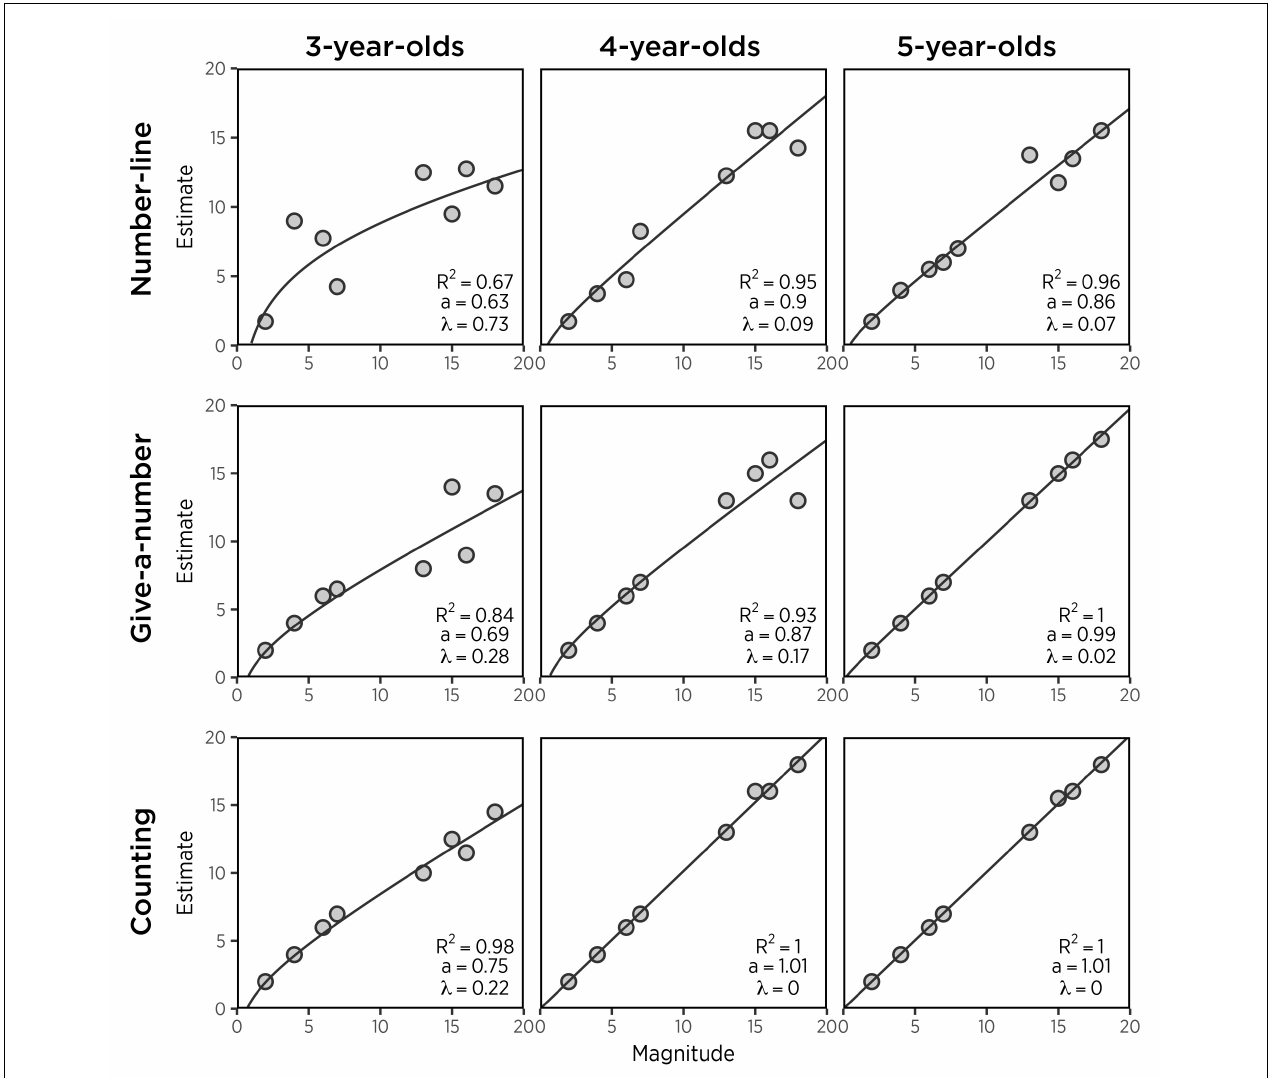
FIGURE 2 | Median responses on quantitative tasks in mapping children by age group.